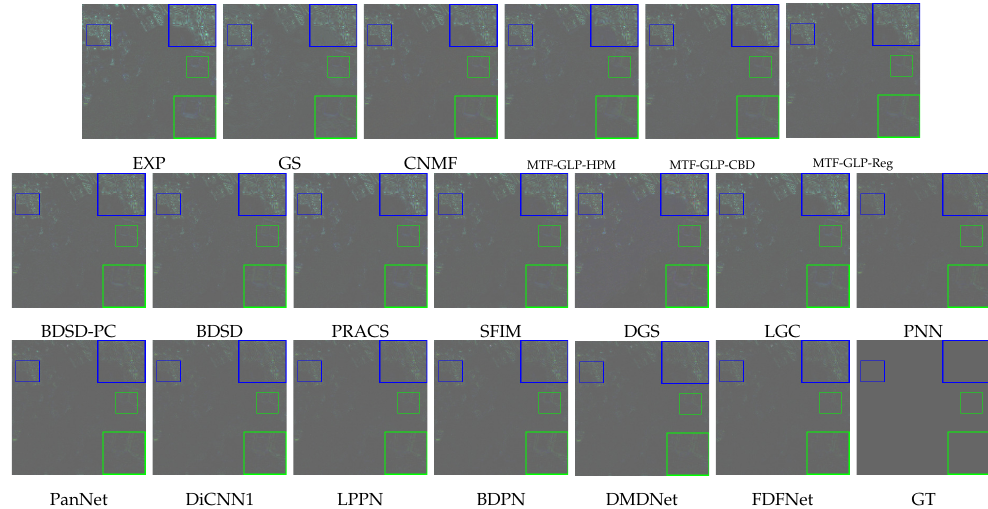
Figure 6. The visual comparisons of the corresponding residual maps using the GT image as reference (shown by bands: 1, 3, and